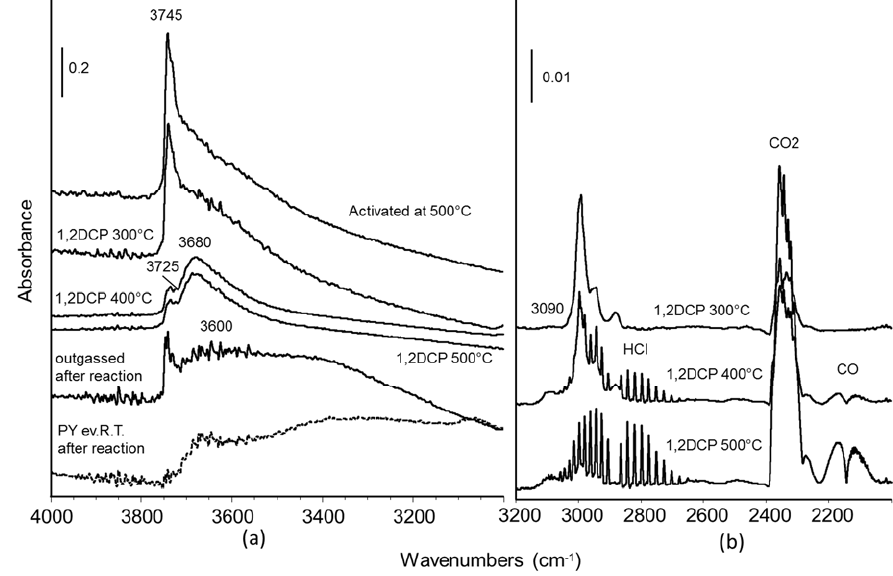
Figure 5. FT ‐ IR spectra of: ( a ) 30Co/SBA hydroxy groups; and, ( b ) FT ‐ IR spectra of gas phase species Figure 5. FT-IR spectra of: ( a ) 30Co/SBA hydroxy groups; and, ( b ) FT-IR spectra of gas phase species arising from 1,2DCP reaction. arising from 1,2DCP